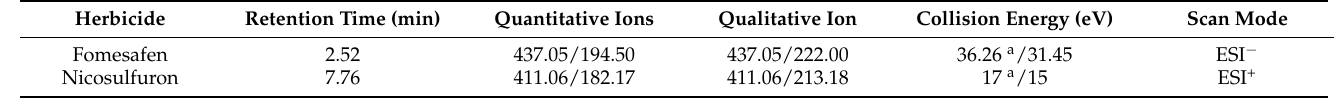
Table 2. HPLC-MS/MS conditions for fomesafen and